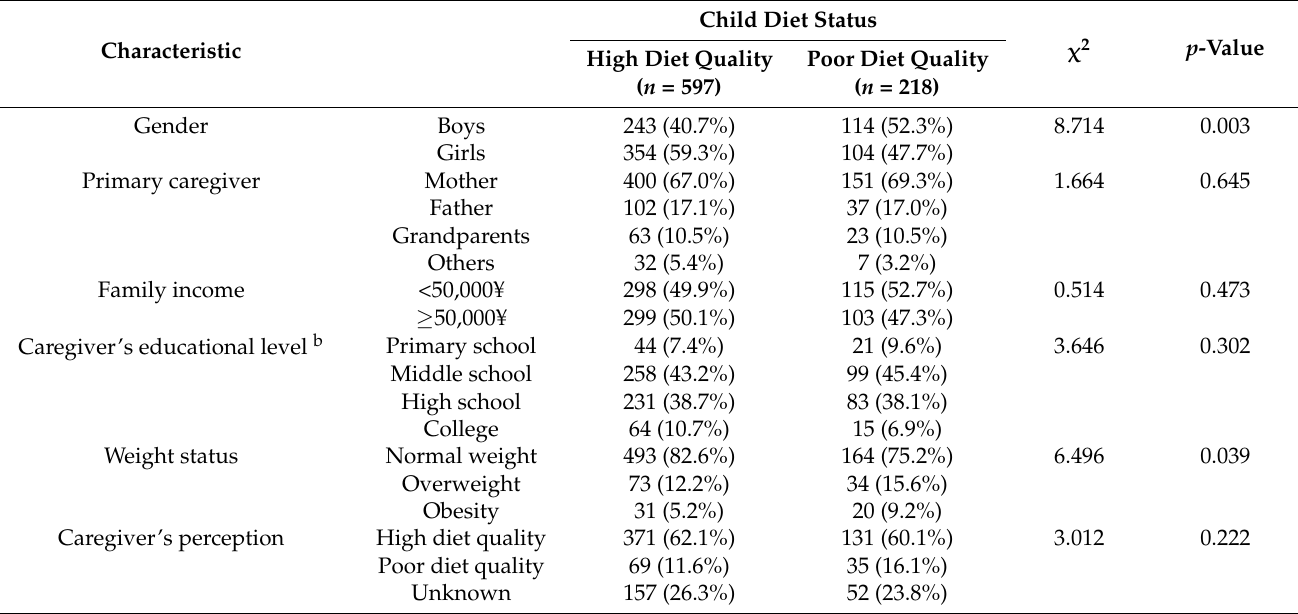
Table 2. Characteristics of study participants a .